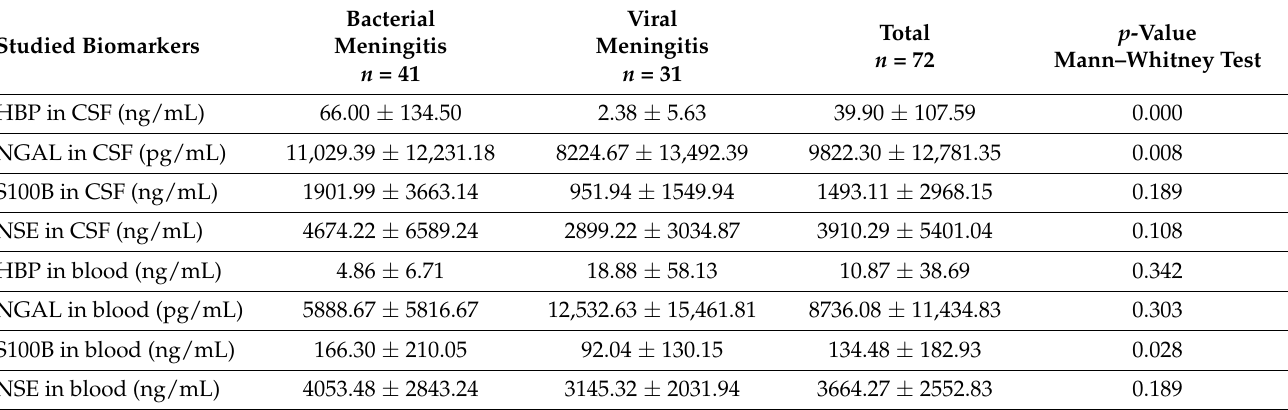
Table 5. HBP, NGAL, S100B, NSE values in CSF and